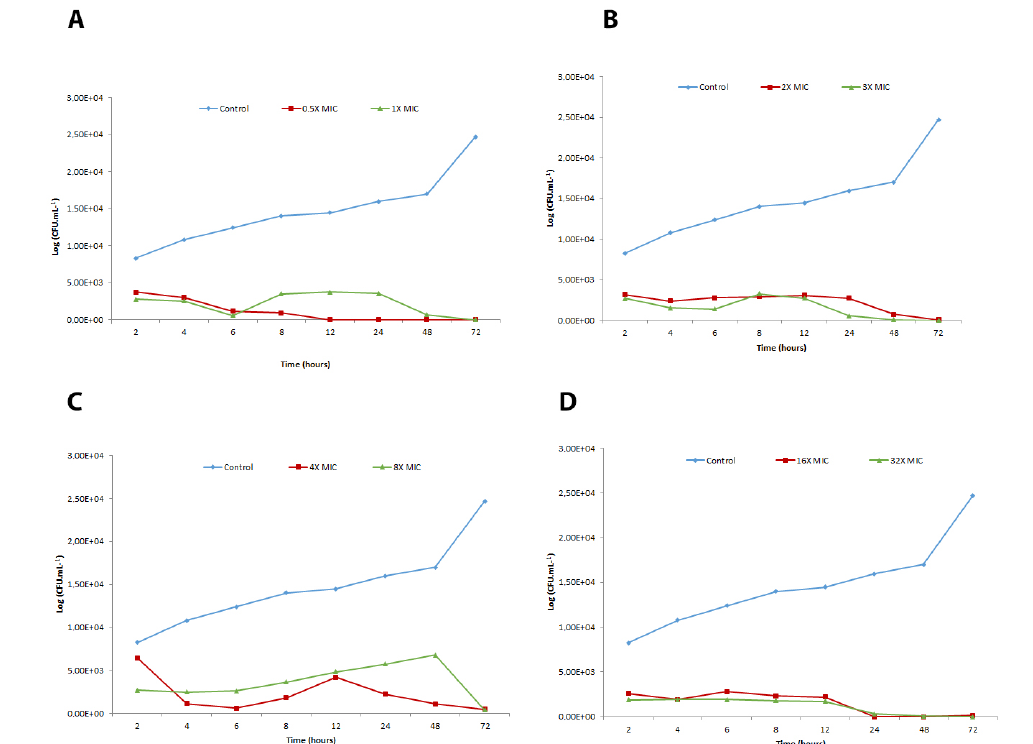
Figure 2. Time-kill curves for lireodenine against strain 17 of Cryptococcus gattii complex. Eight doubling dilutions are plotted, the highest concentration corresponds to 32 × MIC as measured with the EUCAST microdilution method, and the blue line represents growth in absence of lireodenine. The compound was added at timepoint 0 and monitored until 72 h. The limit of detection in the assay was 33 CFU/mL. CFU: colony forming units; MIC: minimum inhibitory concentration.